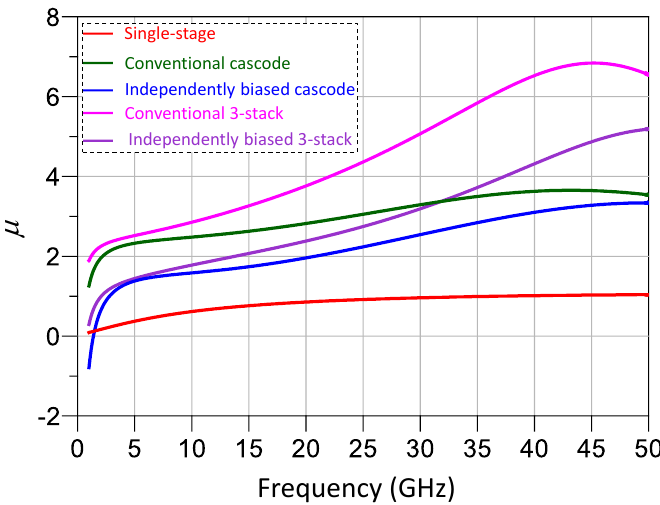
Figure 7. Stability comparison among configurations.